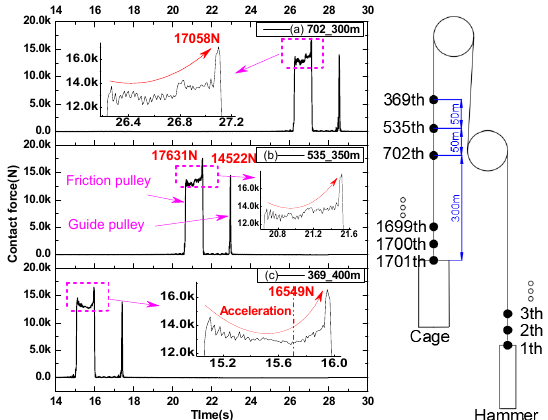
Figure 15. Contact force produced by the rope wrapping the pulleys. ( a ) Rope 300 m above cage; ( b ) rope 350 m above cage; ( c ) rope 400 m above cage.